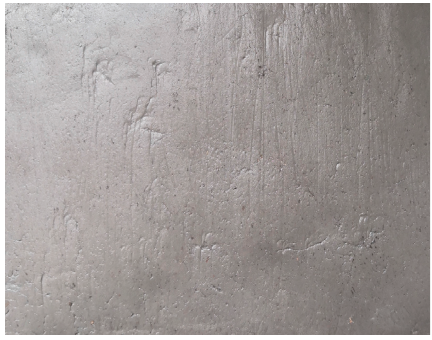
Figure 3: Picture of Duxseal.